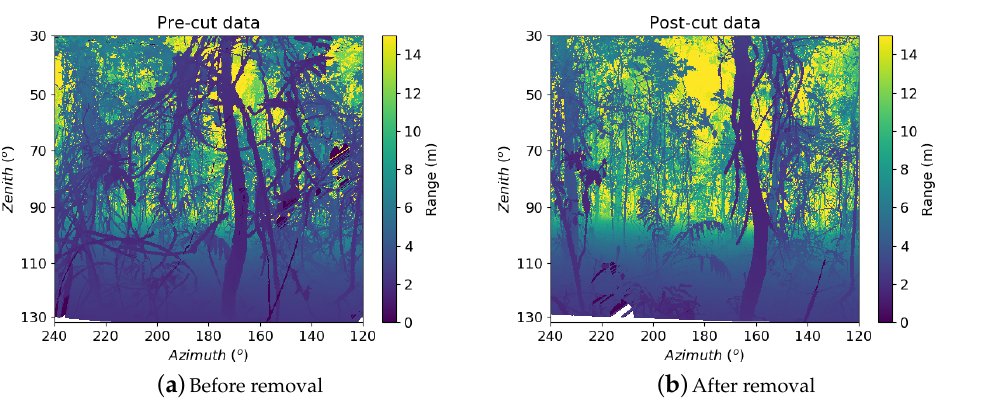
Figure 3. View of terrestrial LiDAR data from one scan position of the removal plot with azimuth ranging from 120 ◦ to 240 ◦ and zenith ranging from 30 ◦ to 130 ◦ . The data is colored according to the range of the laser pulse.